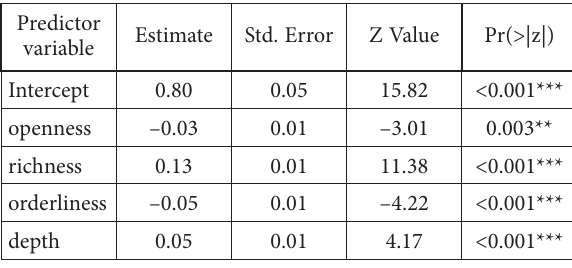
Table 5. The output of the final GLM models for “complexity ~ openness + richness + orderliness + depth” Predictor variable